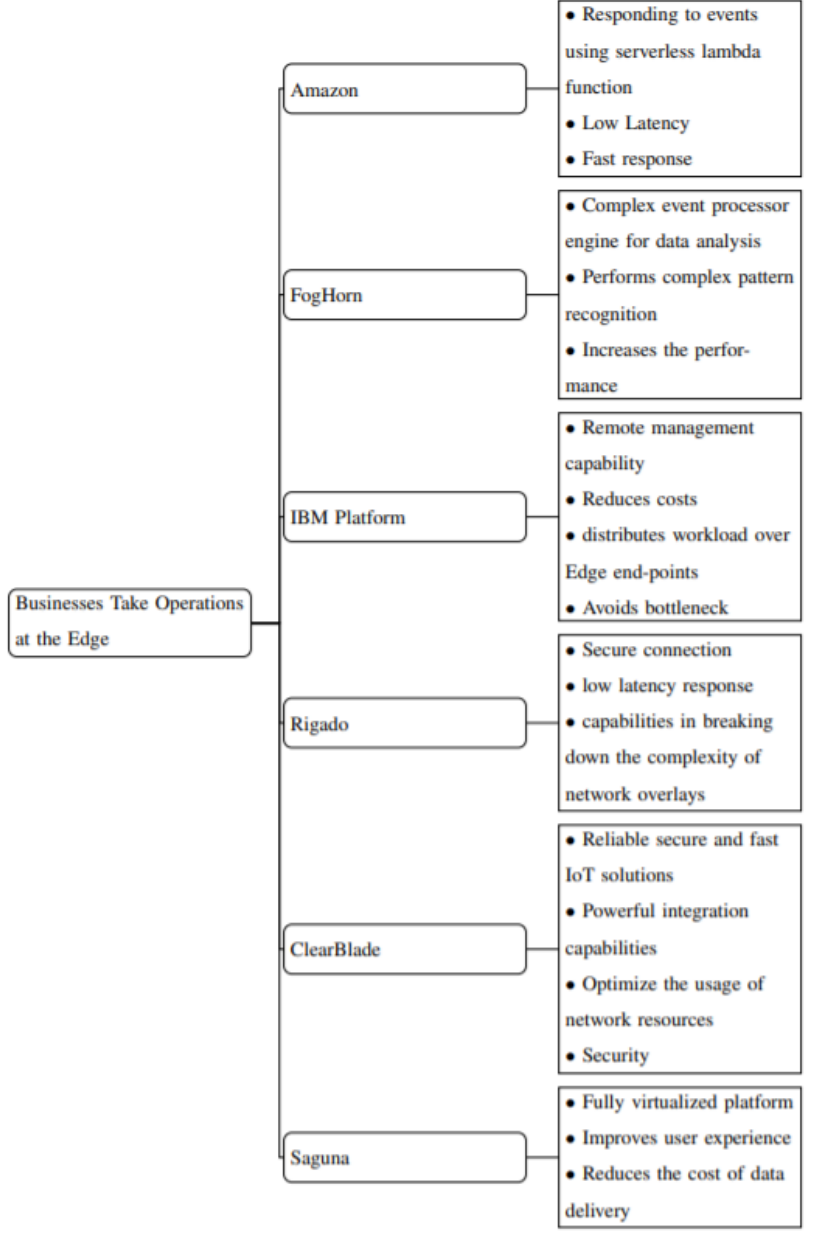
Figure 5. Businesses taking operations at the edge: Amazon, ClearBlade, FogHorn, IBM, Rigado, Saguna